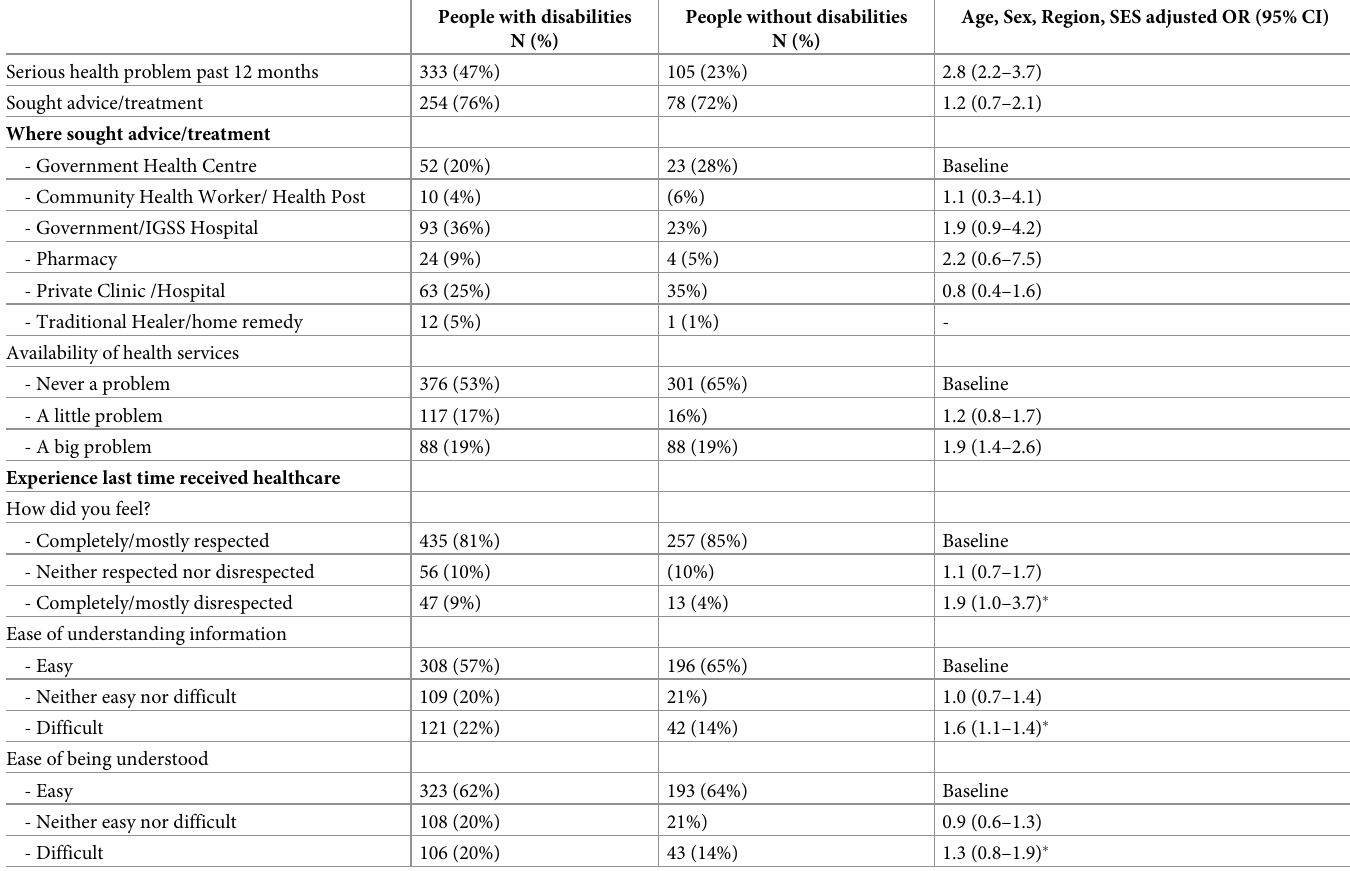
Table 2. Healthcare seeking and experience among people with and without